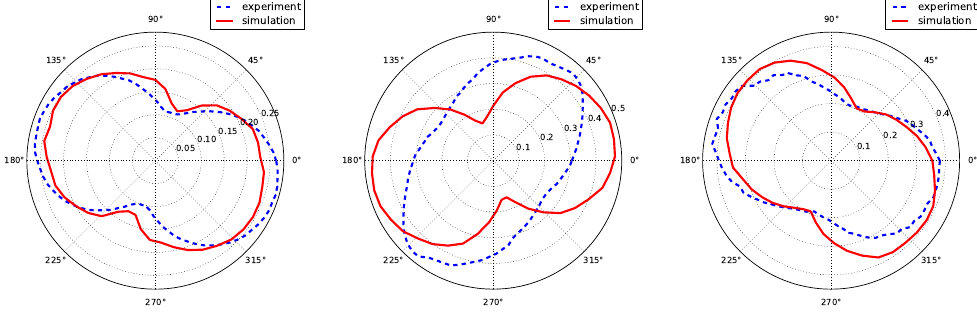
Figure 11. Comparison between experimentally simulated full width of the effective misorientation (FWEM) at ε = 0.34 10 − 2 for the three investigated ×